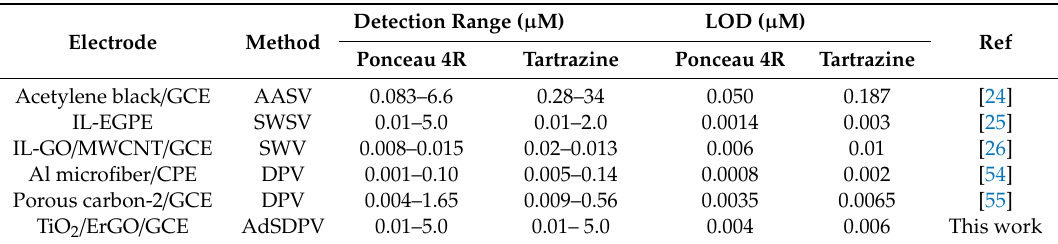
Figure 8. ( A ) DPV curves of ponceau 4R and tartrazine with their concentrations varying from 0.01 to 5.0 µ M, a → k: 0.01, 0.003, 0.05, 0.08, 0.10, 0.30, 0.50, 0.80, 1.0, 3.0 and 5.0 µ M; ( B ) plots of the anodic peak currents of ponceau 4R as the function of the natural logarithm of its concentrations in the range of 0.01–5.0 µ M ( n = 3) and ( C ) plots of the anodic peak currents of tartrazine as the function of natural logarithm of its concentrations in the range of 0.01–5.0 µ M ( n = 3). Table 1. Comparison on analytical performance of the simultaneous detection of ponceau 4R and tartrazine with previously reported electrodes.